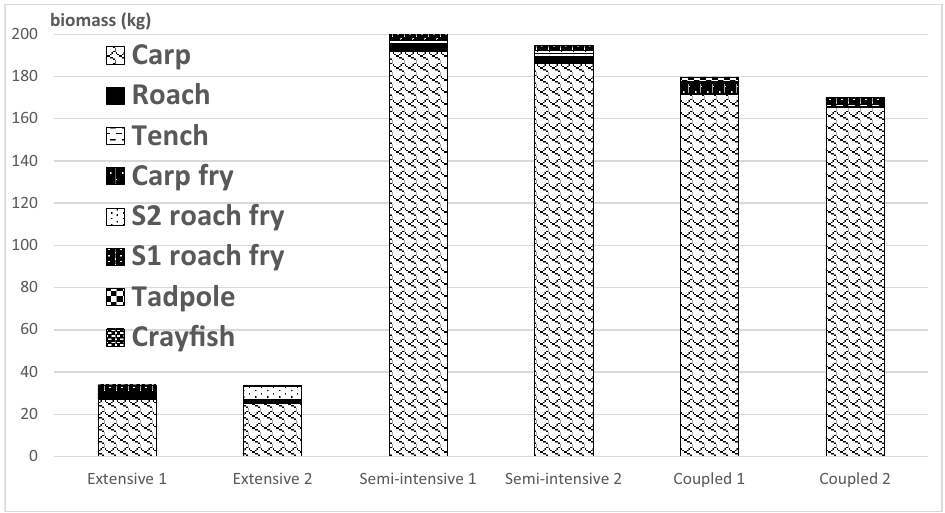
Fig. 2. Cumulative animal biomass harvested at the end of the experiment in carp polyculture ponds: extensive (without formulated feed), semi- intensive (with feed and double fi sh density) and coupled (semi-intensive þ planted lagoon). Table 4. Means of chemical, physical and biological indicators of the water in ponds for each treatment during the experiment. Extensive Semi-intensive Coupled Indicator Mean SD 1 Mean SD 1 Mean Signi fi cance 2 Temperature ( ° C)